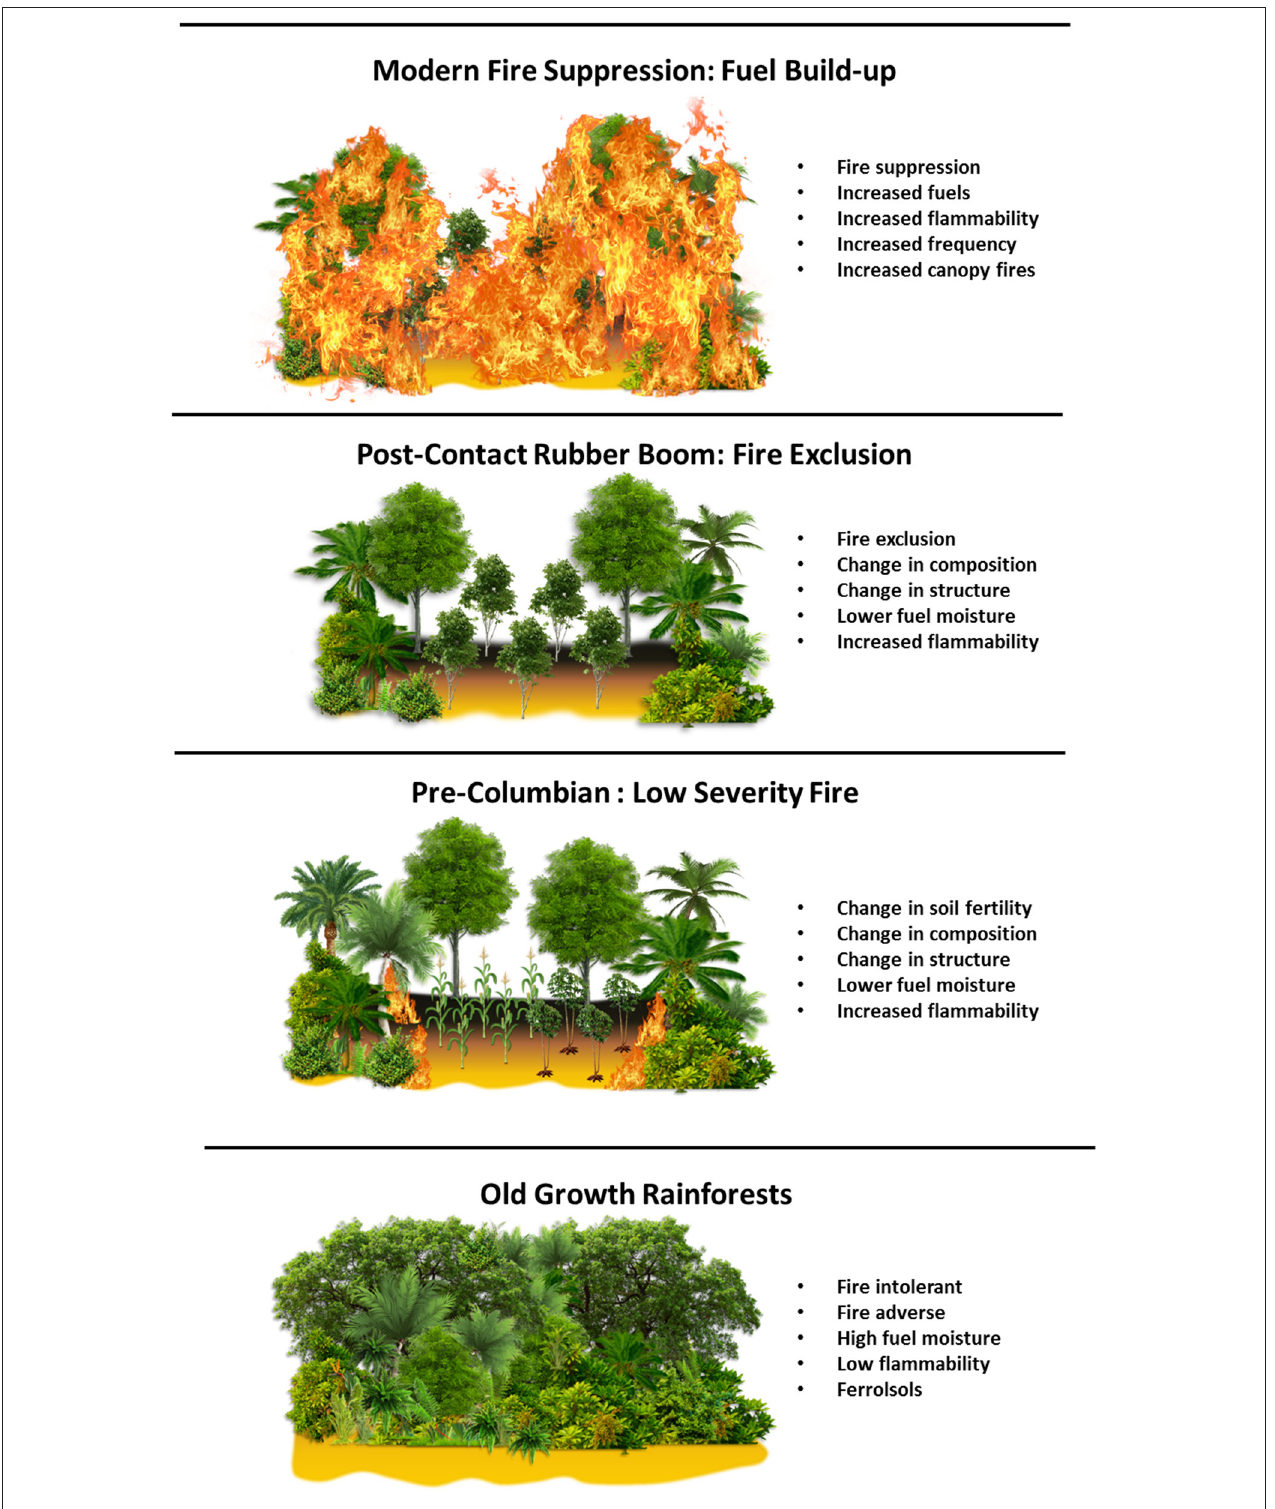
FIGURE 10 | A conceptual figure of phases of the history of human land use and fire management in the eastern Amazon.